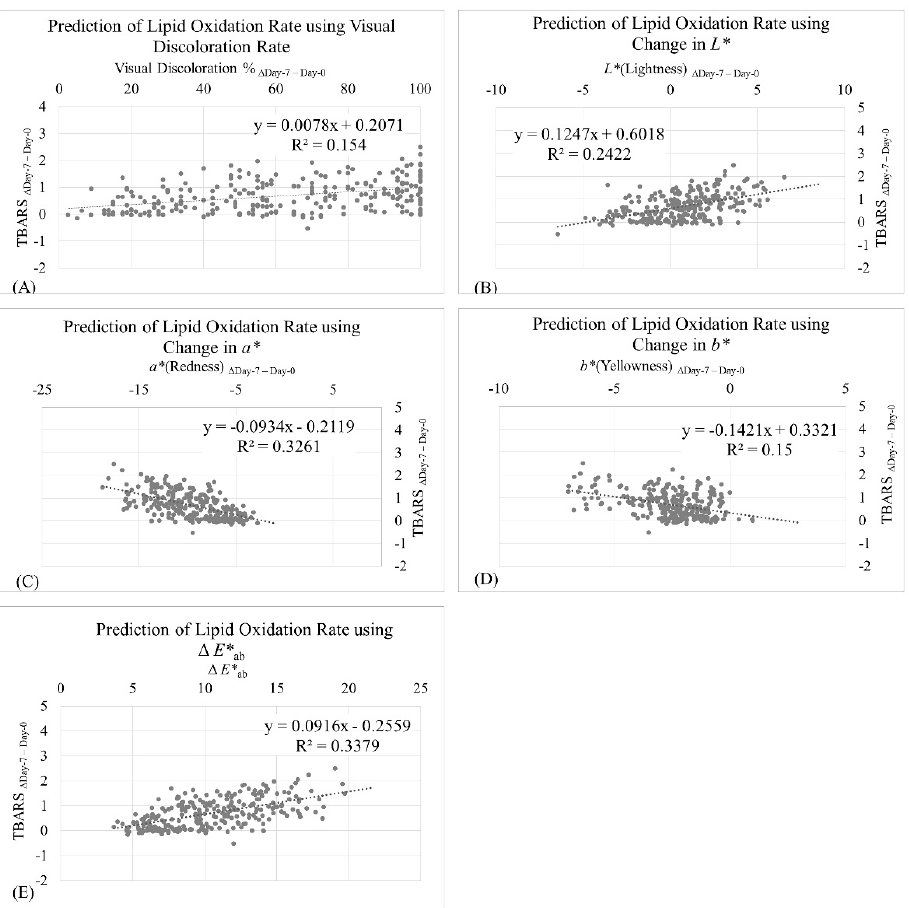
Figure 4. Prediction of lipid oxidation rate (TBARS Δ Day-7–Day-0 ) using visual discoloration rate ( Δ Day- rate ( ∆ Day-7–Day-0 ) ( A ); change in instrumental L * ( ∆ Day-7–Day-0 ) ( B ); change in instrumental a * 7–Day-0 ) ( A ); change in instrumental L * ( Δ Day-7–Day-0 ) ( B ); change in instrumental a * ( Δ Day-7–Day-0 ) ( C ); change in instrumental b * ( Δ Day-7–Day-0 ) ( D ); and change in instrumental Δ E * ab ( E ) as independent var- ( ∆ Day-7–Day-0 ) ( C ); change in instrumental b * ( ∆ Day-7–Day-0 ) ( D ); and change in instrumental ∆ E * ab ( E ) iables. as independent